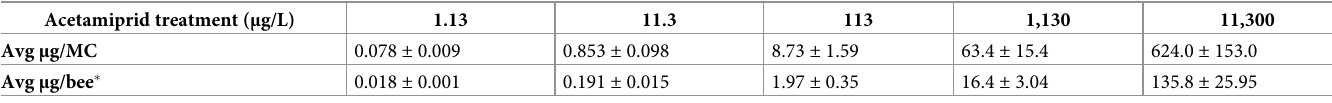
Table 1. Estimated acetamiprid utilized by whole microcolonies and individual workers. Acetamiprid treatment ( μ